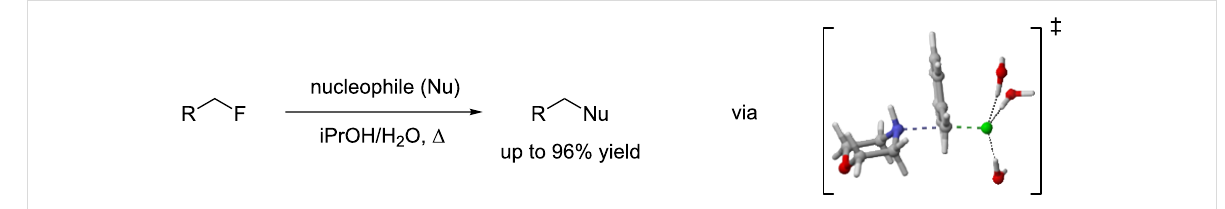
Figure 1: S N 2 reaction of activated alkyl fluorides and calculated transition state for the reaction of morpholine with benzyl fluoride with three mole- cules of water.